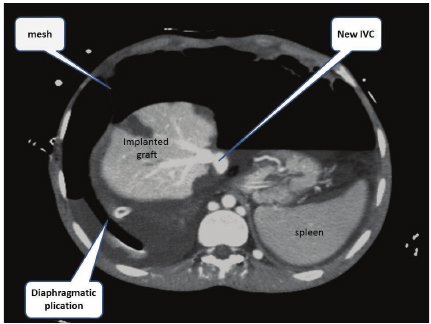
Figure 6: CT view after living donor liver transplantation. Dia- phragmatic plication and new IVC are